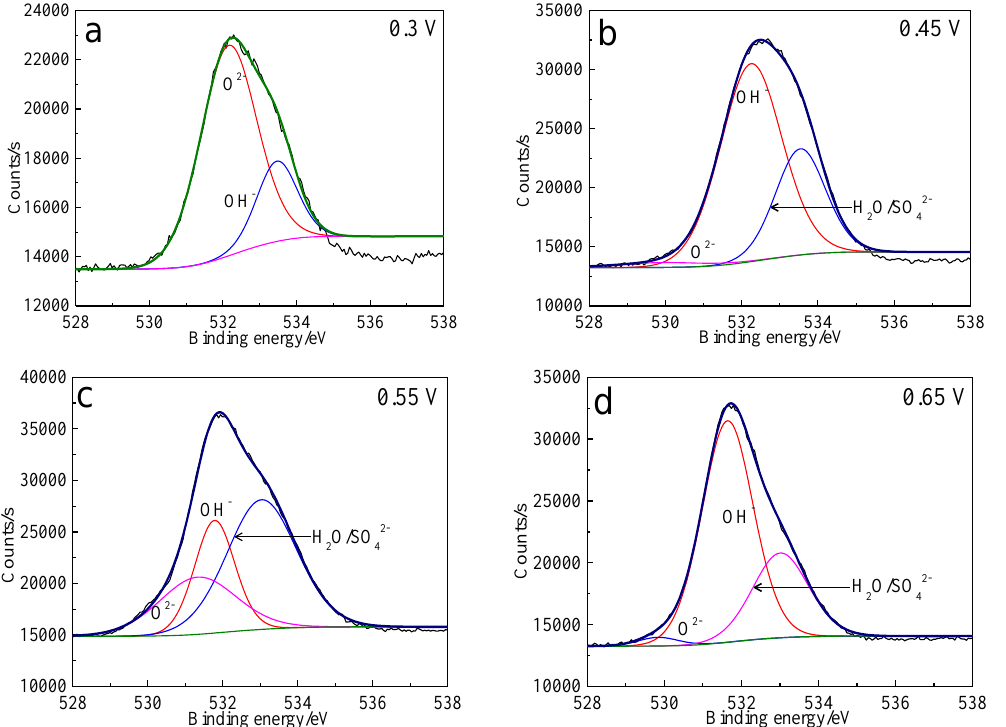
Figure 15. XPS spectra of O 1s peaks of bornite surface after treating by different potential of 0, 0.3, 0.45, 0.55, 0.65 V, respectively: ( a ) 0.3 V; ( b ) 0.45 V; ( c ) 0.55 V; ( d ) 0.65 V (Implemented on the model of ESCALAB 250Xi of Al Kα X-ray source with 20 eV constant pass energy and 0.1 eV/step; Fitted by Thermo Avantage 5.52, C 1s 284.8 eV as reference, Shirley method, Gaussian-Lorentzian function).